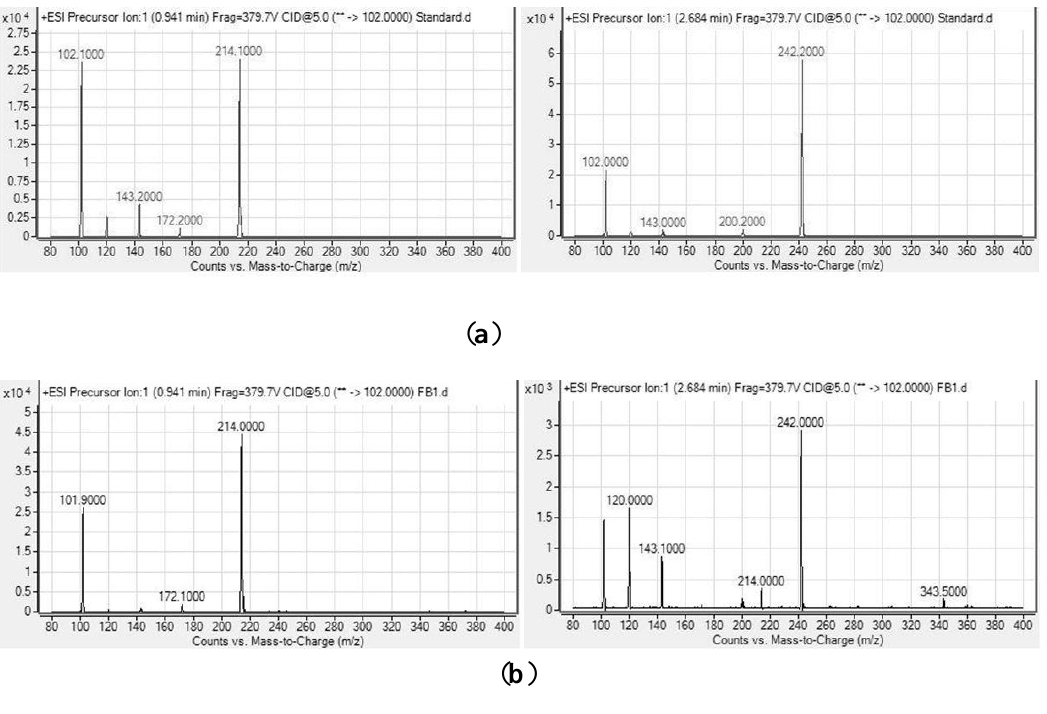
Figure 4. Mass spectra of ( a ) Synthetic AHLs standard; ( b ) AHLs extracted from the cell-free supernatant of H. alvei FB1, showing the peaks of targeted AHLs: 3-oxo-C6-HSL ( m/z 214) and 3-oxo-C8-HSL ( m/z 242) along with the product ion peaks ( m/z